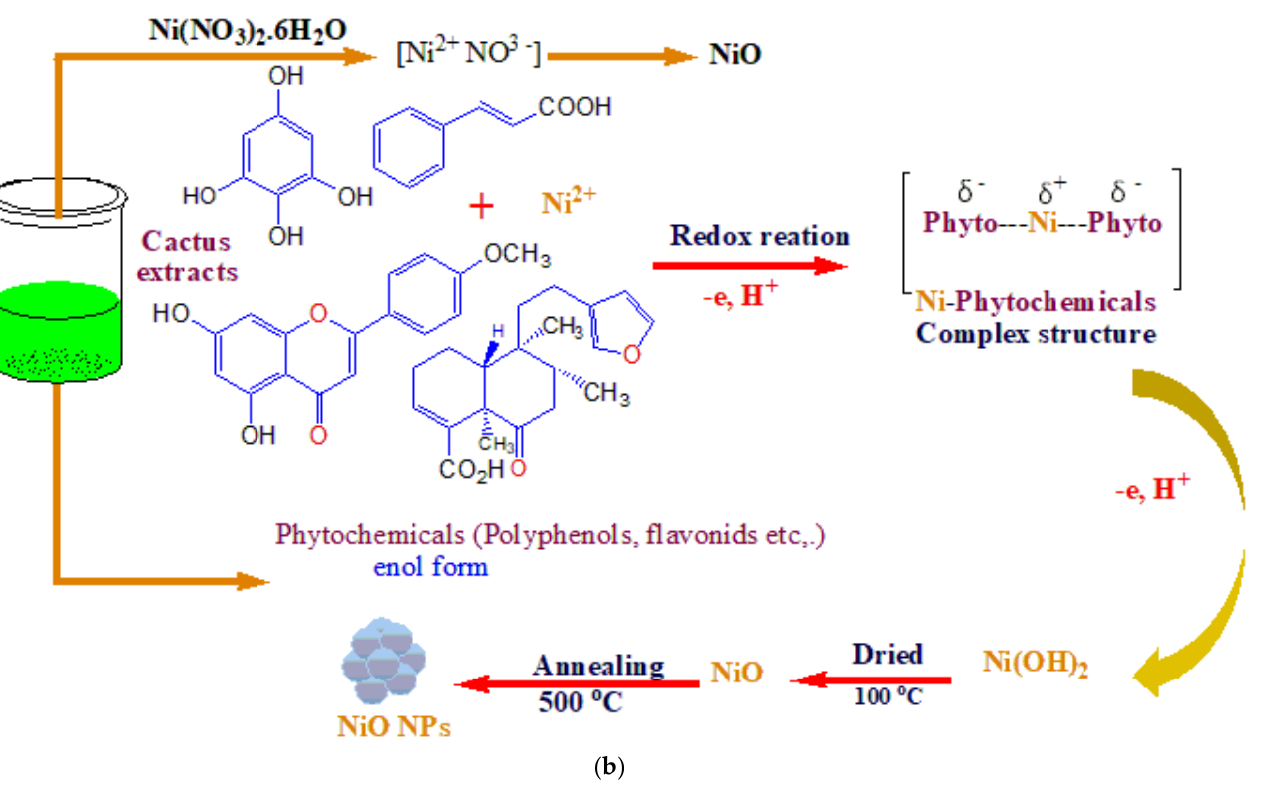
Figure 1. ( a ). Schematic of the green synthesis process and thin film deposition of NiO Figure 1. ( a ) Schematic of the green synthesis process and thin film deposition of NiO nanoparticles. nanoparticles. ( b ). Possible mechanism of NiO nanoparticle formation by Opuntia ficus Indica leaf ( b ) Possible mechanism of NiO nanoparticle formation by Opuntia ficus Indica leaf extract.